Question: What kind of plot is shown here?
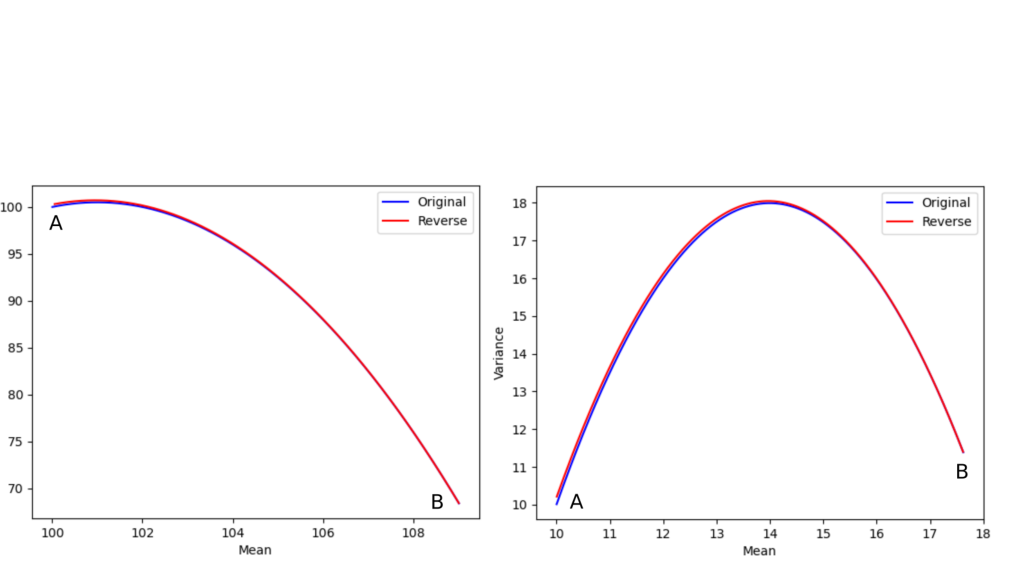
Answer: line